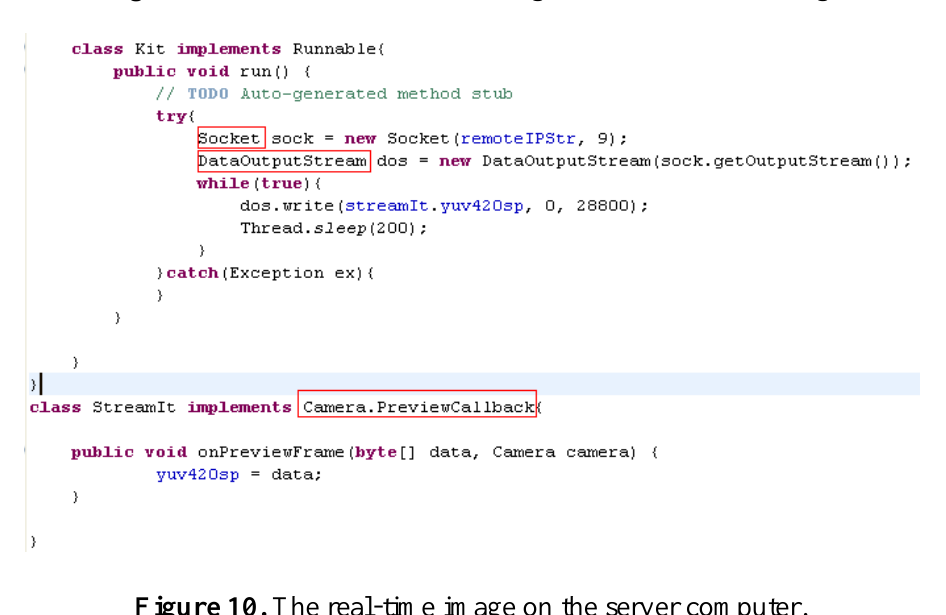
Figure 9. The remote real-time image transformation setting.